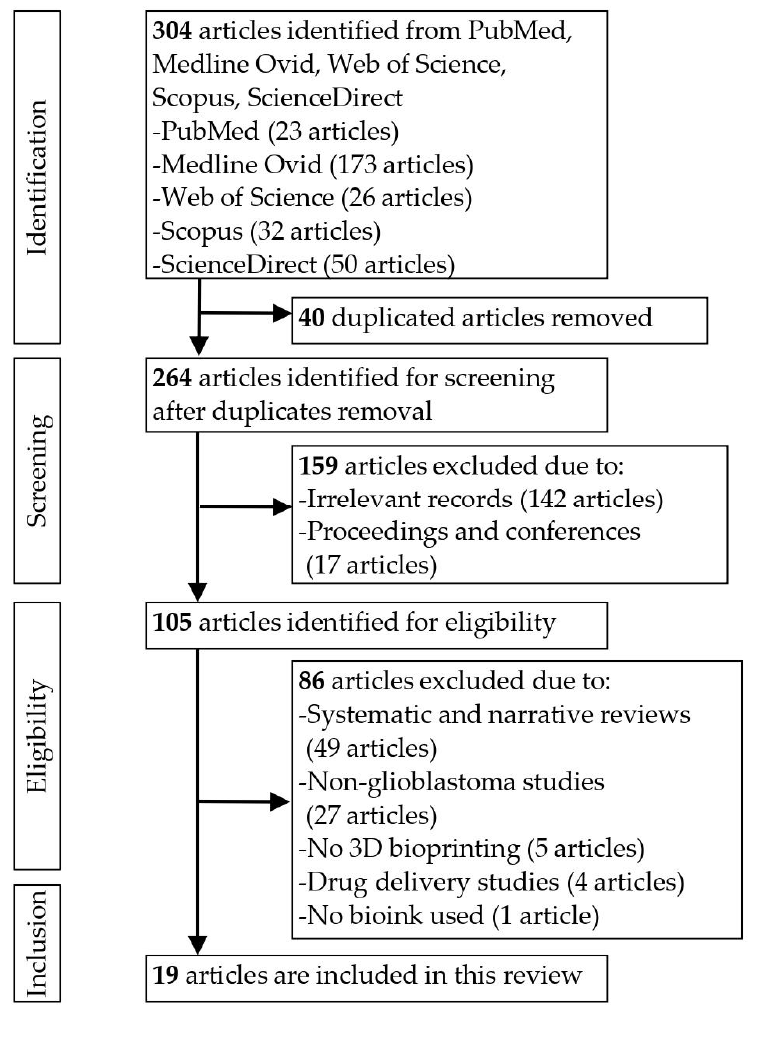
Figure 1. PRISMA flow chart.